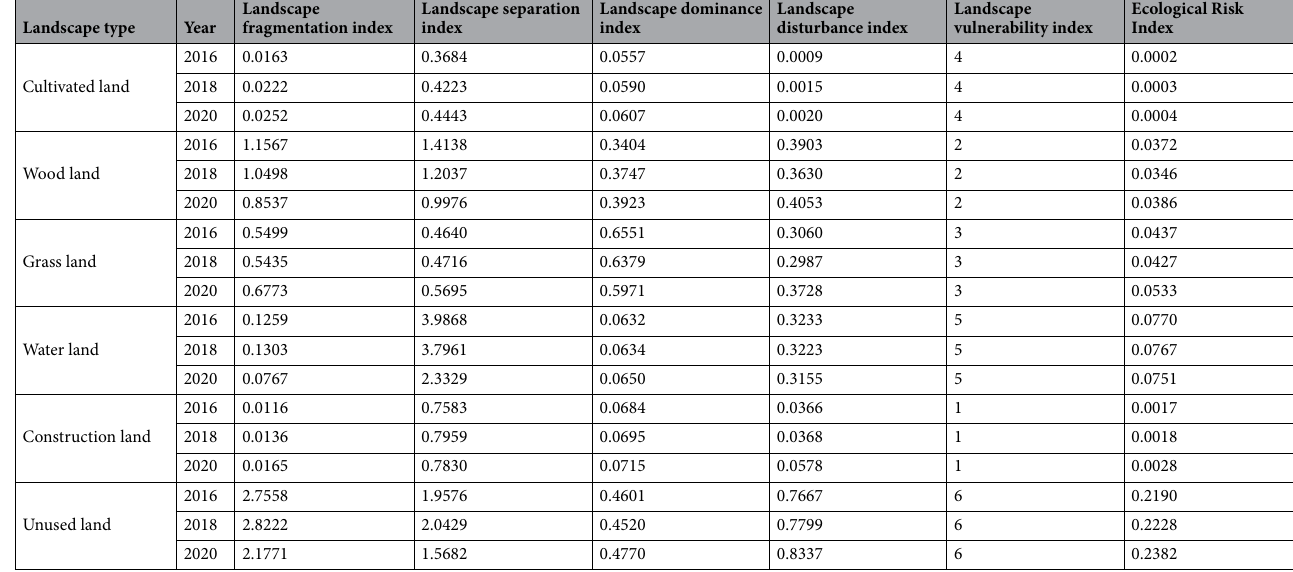
Table 4. The landscape pattern index of different land types along the highway from 2016 to